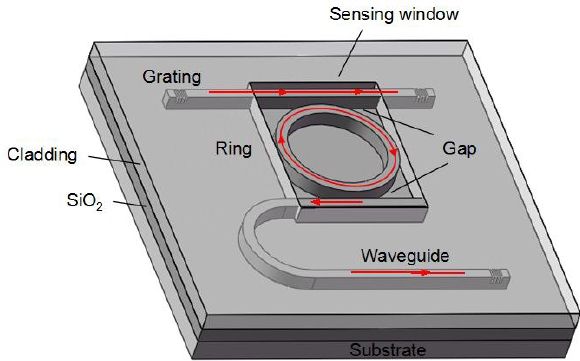
Figure 1. Schematic of the microring resonator sensor.